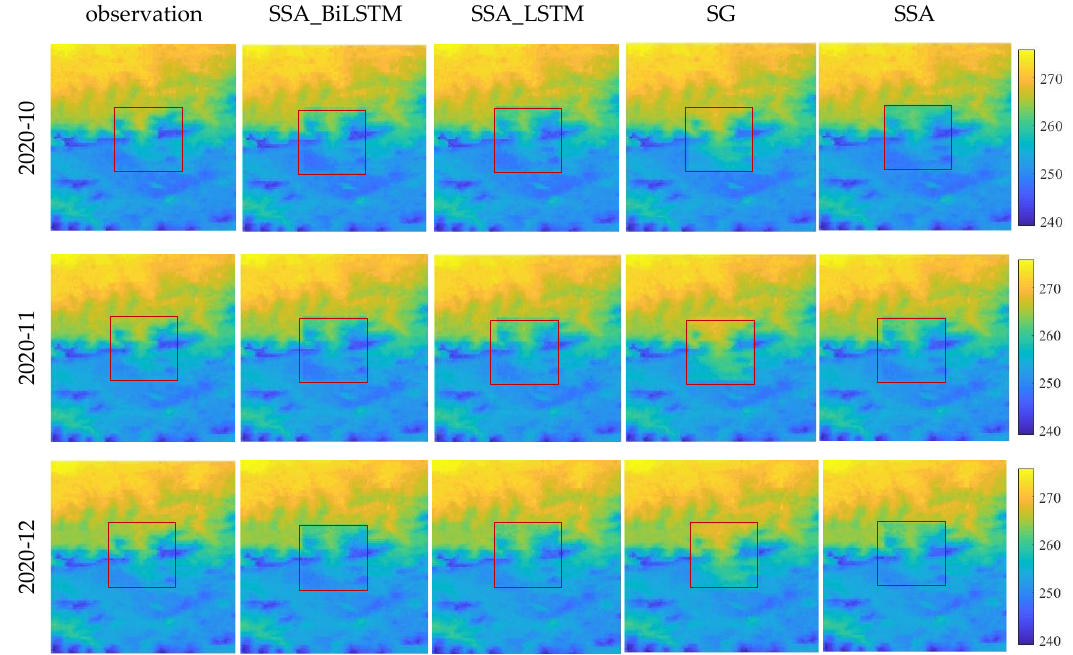
Figure 8. Comparison between the images reconstructed using different methods. The red blocks in the charts above represent the areas where the missing data are reconstructed. 2020-10, 2020-11 and 2020-12 represent issues 10, 11, and 12 of 2020, respectively.